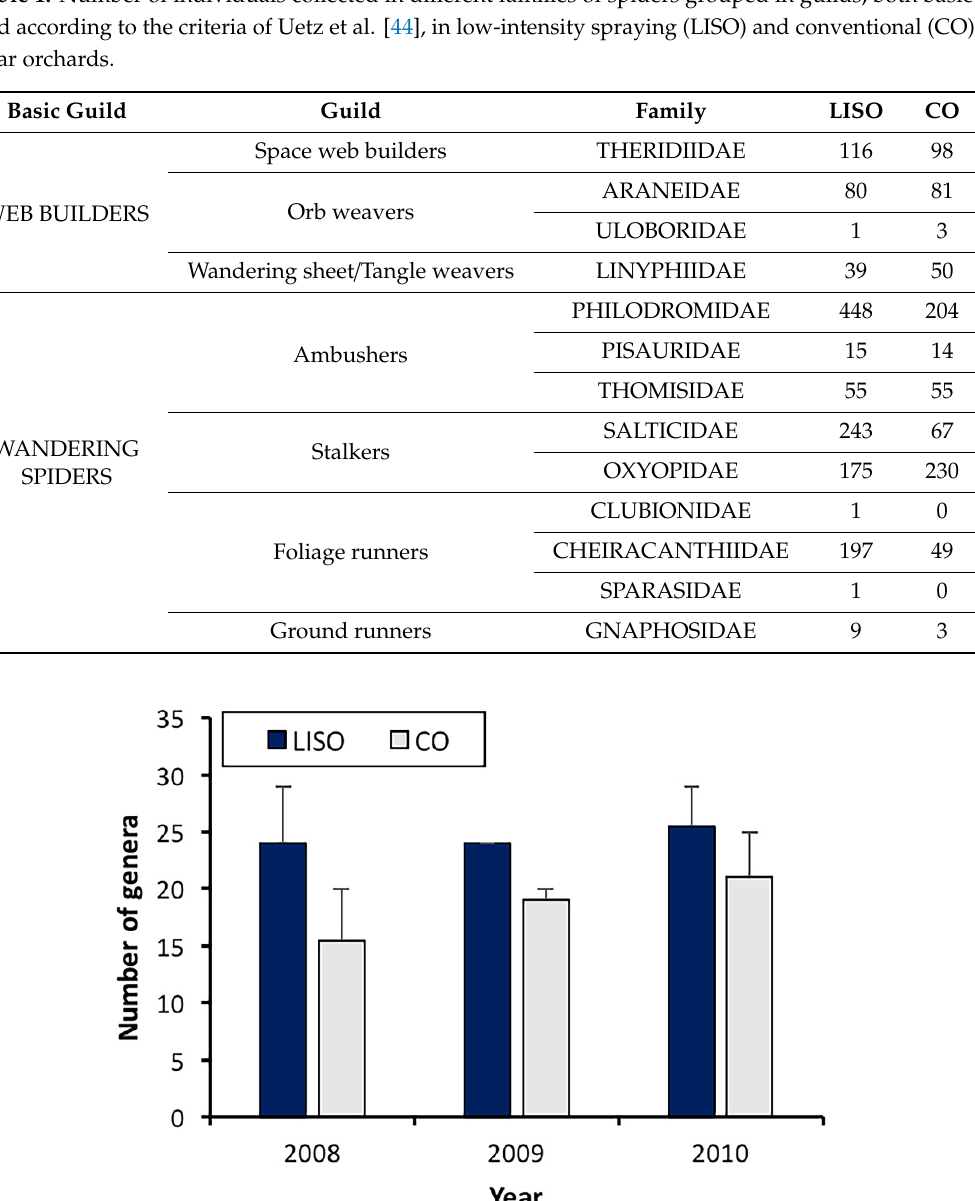
Figure 1. Annual richness of spider genera (mean ± SE) in pear orchards. LISO, low-intensity spraying orchards; CO, conventional orchards.